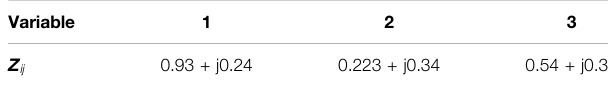
TABLE 1 | Line impedance data.